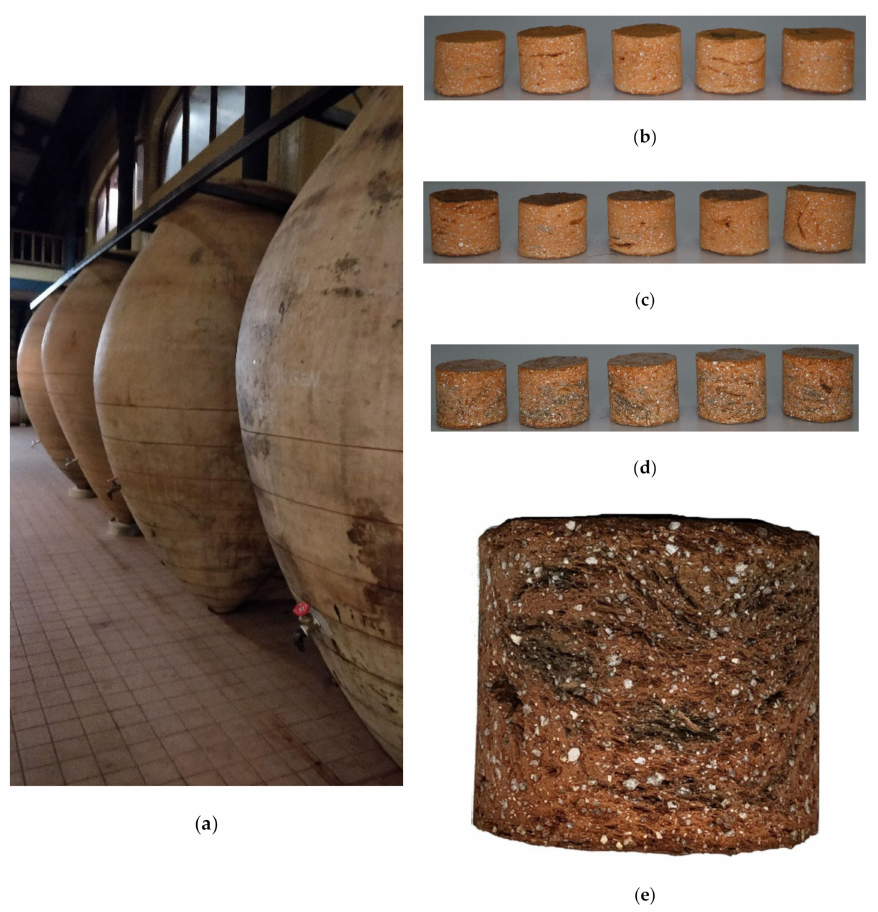
Figure 3. ( a ) Vessels in Prado Rey winery (Burgos, Spain) and ( b ) uncoated raw test specimens; ( c ) specimens coated with 85% colophony + 15% beeswax; ( d ) specimens coated with 85% beeswax + 15% almond oil and ( e ) detail of the composition of the vessel